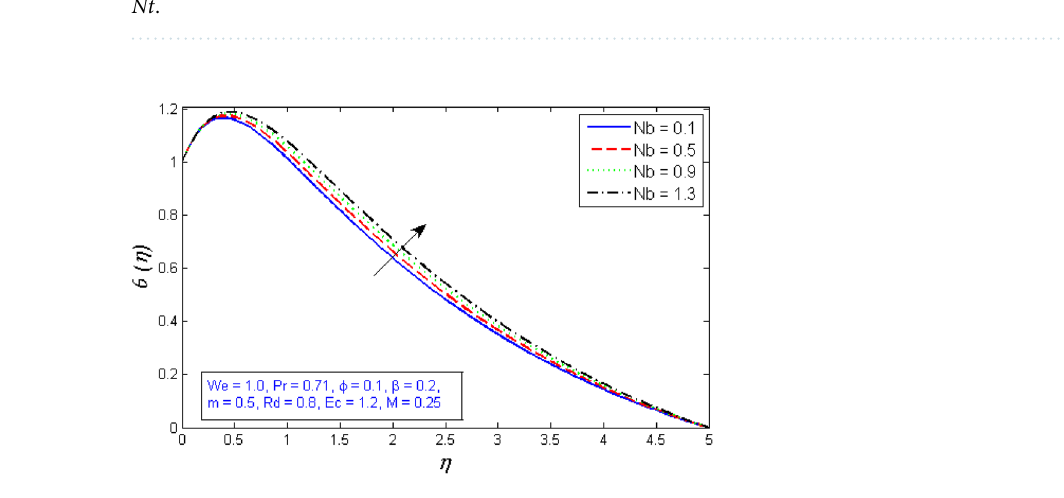
Figure 21. Represents variation of temperature distribution for several number of Brownian motion Nb